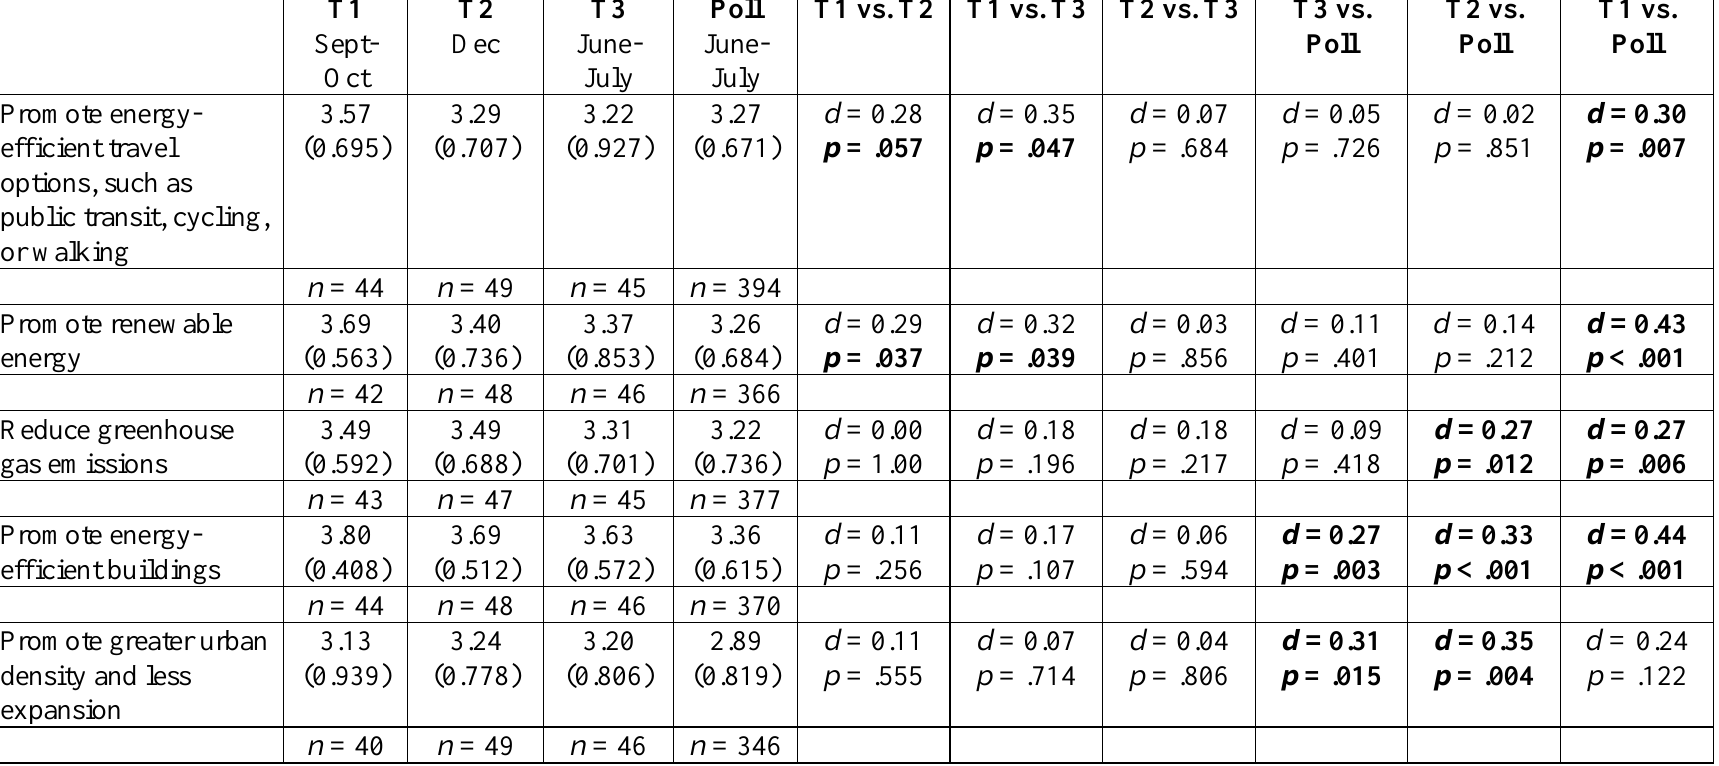
Table 3: Policy Preferences for Panelists and Public Opinion Poll